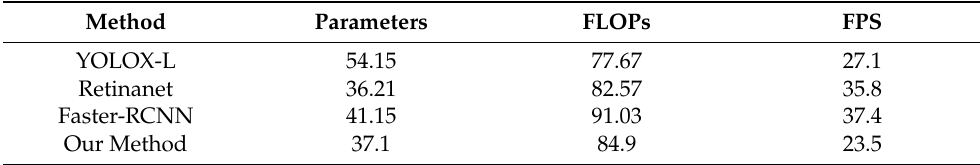
Table 2. Efficiency